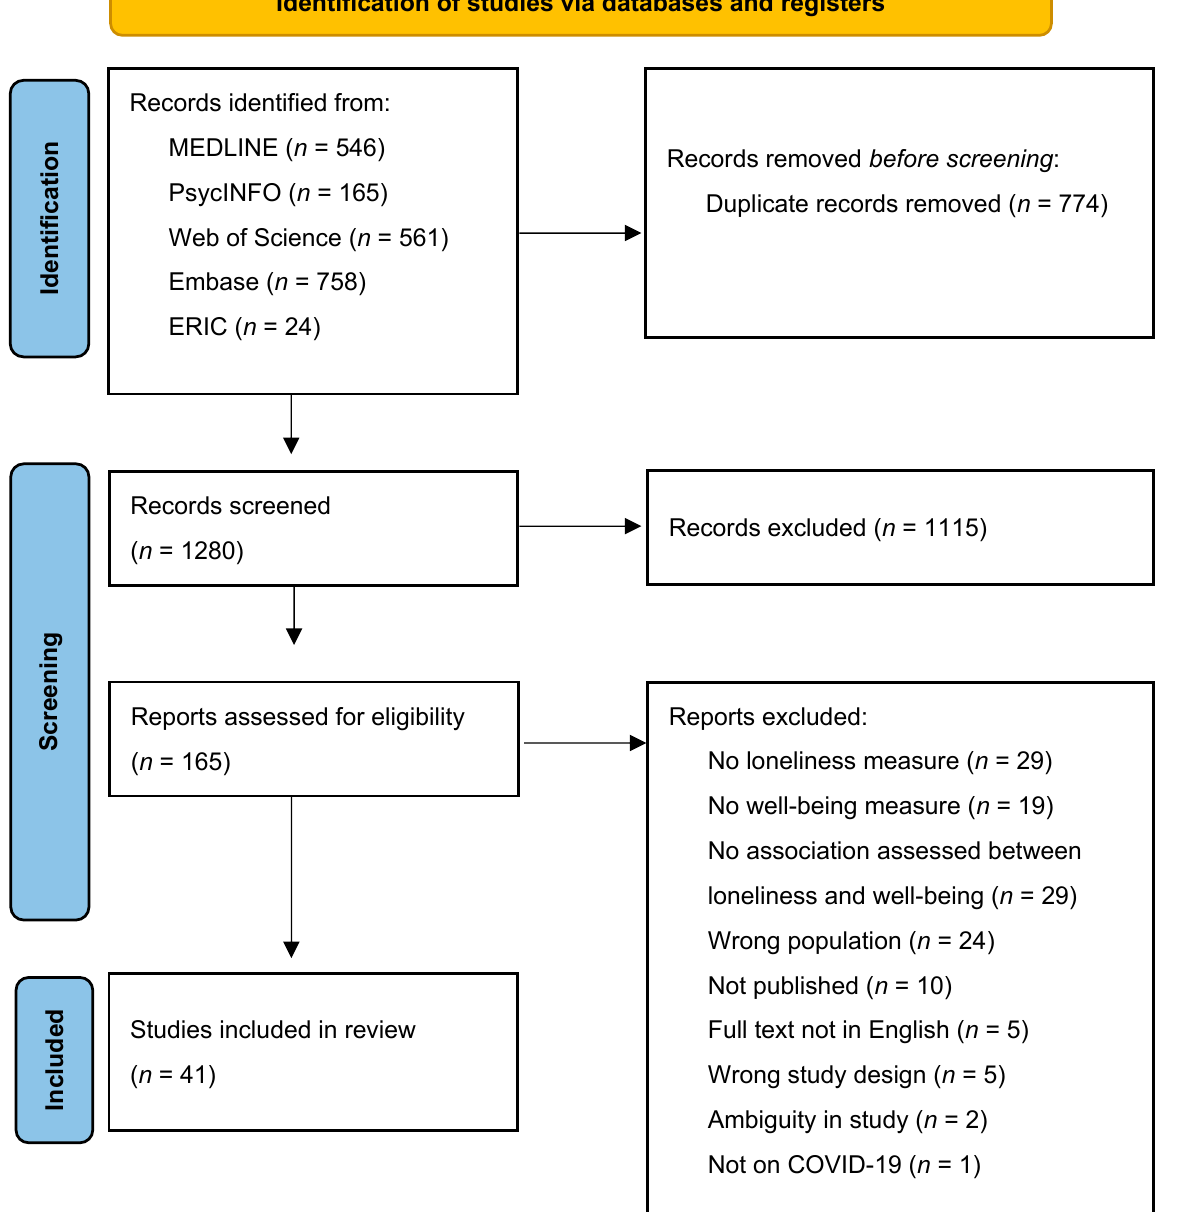
Figure 1. PRISMA Flow Diagram for Systematic Review Study Selection. Note. PRISMA = Preferred Reporting Items for Systematic Reviews and Meta-Analyses. From Page et al.